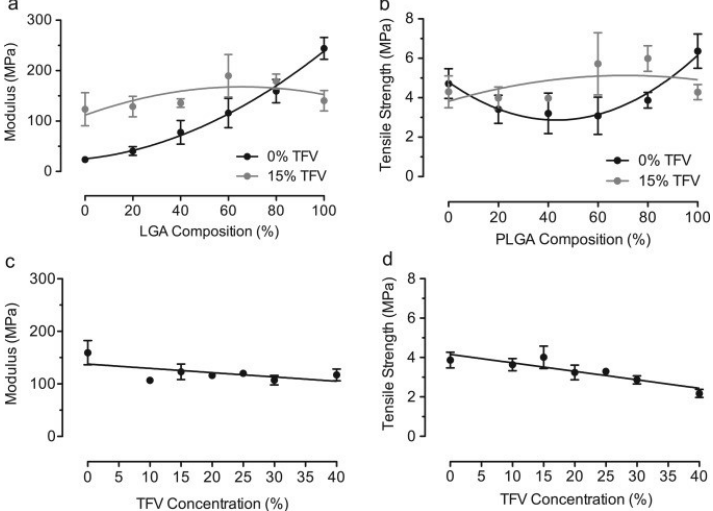
Fig. 4 Maximum tensile stress on PCL